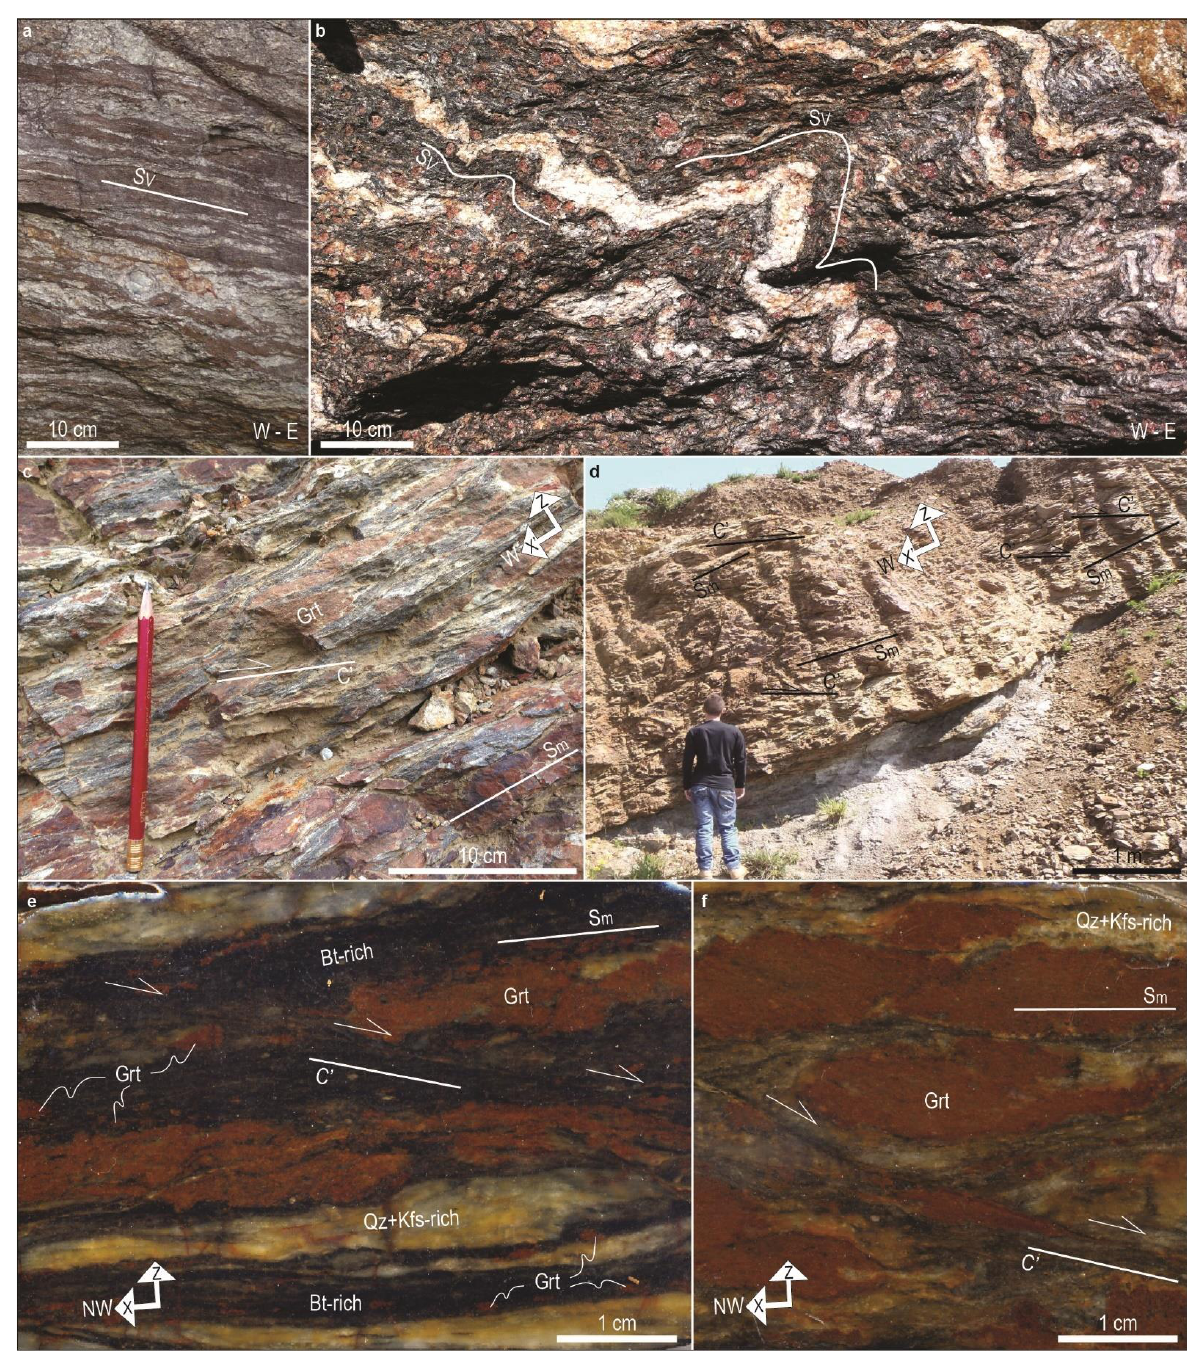
Figure 3. ( a , b ) Field examples of layering in migmatitic metapelite; note the evident folding of the layering. ( c , d ) Field examples of mylonitic metapelite cropping out in the Passo Fosso del Lupo–Serre dei Meriani area. ( e , f ) Polished rock slabs of mylonitic metapelite (sample VF46aAM and VF46bAM, respectively; see Figure 2 for location). S V = Variscan main foliation, S m = main mylonitic foliation, C’ = shear bands, Grt = garnet, Bt = biotite, Qz = quartz, Fsp = feldspars, X and Z = maximum and minimum strain axes, respectively, X’ = nearly X-axis. Mineral abbreviations after